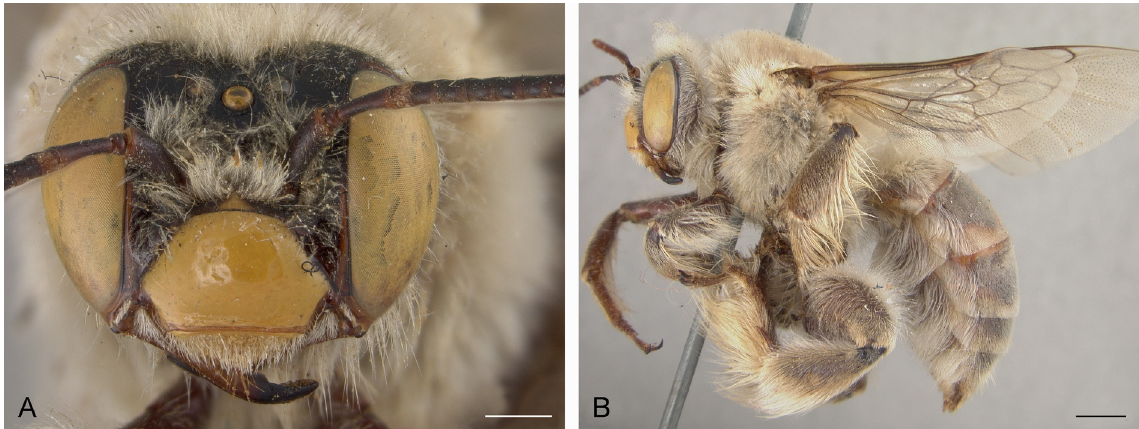
Fig. 23. Centris morsei Cockerell, 1897, holotype, ♂ (NMNH; USNM ENT 00534205). A . Frontal view. B . Habitus, lateral view. Scale bars: A = 1 mm; B = 2